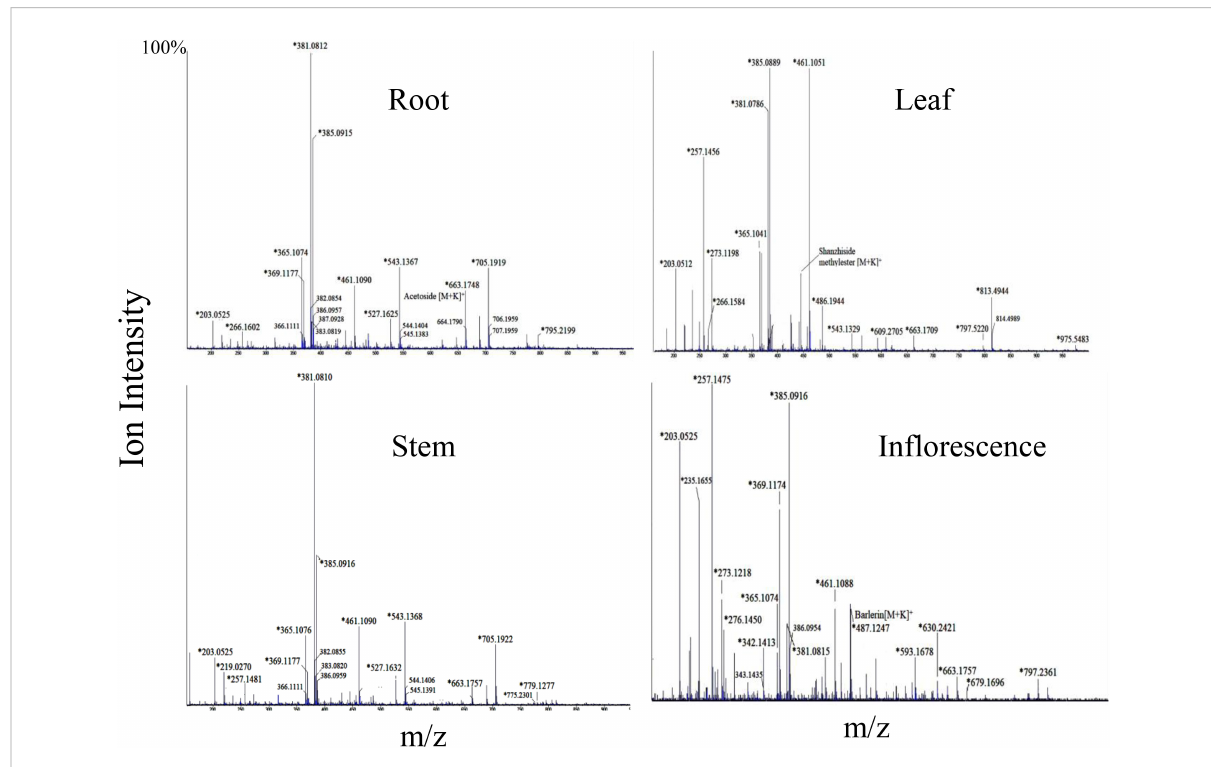
FIGURE 4 Mass spectra of root, leaf, stem and in fl orescence of Barleria cristata showing MS1 ions in positive ion mode. Ions marked with asterisk (*) symbol are the parent ion and without the symbol are their